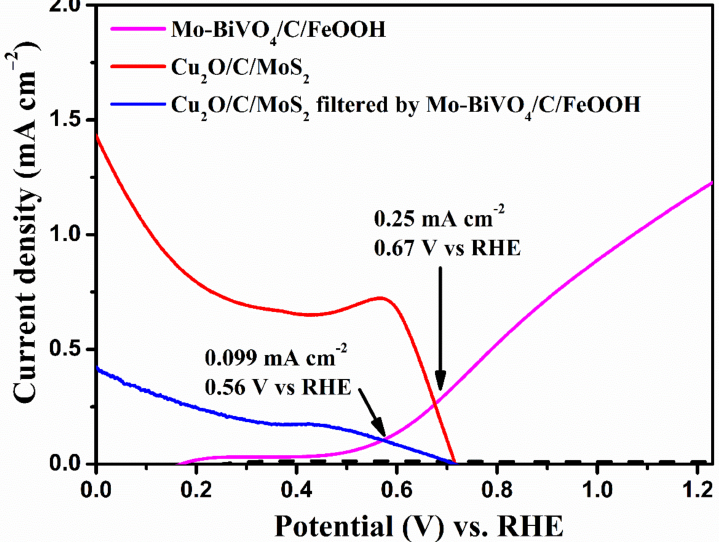
Figure 6. Overlay LSV curves of the Mo-BiVO 4 /C/FeOOH photoanode with the Cu 2 O/C/MoS 2 photocathode to find the operating point of the tandem cell measured at 0.1 M Na 2 SO 4 (pH 6) using an AM 1.5 G light source with a power intensity of 100 mW cm − 2